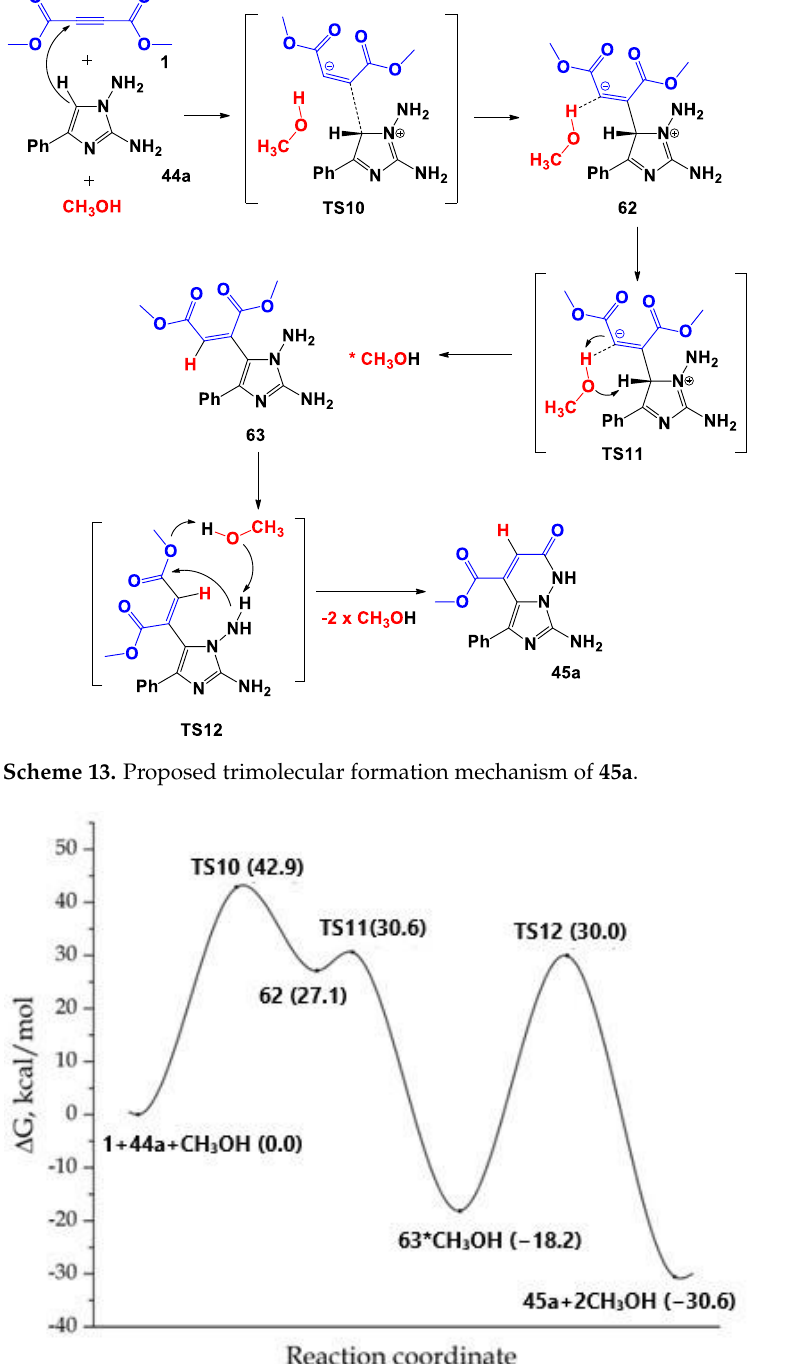
Figure 7. MEP for the trimolecular reaction concerning the formation of product 45a . The total energy of the starting reagents 1 , 44a and methanol was taken as the reference point.